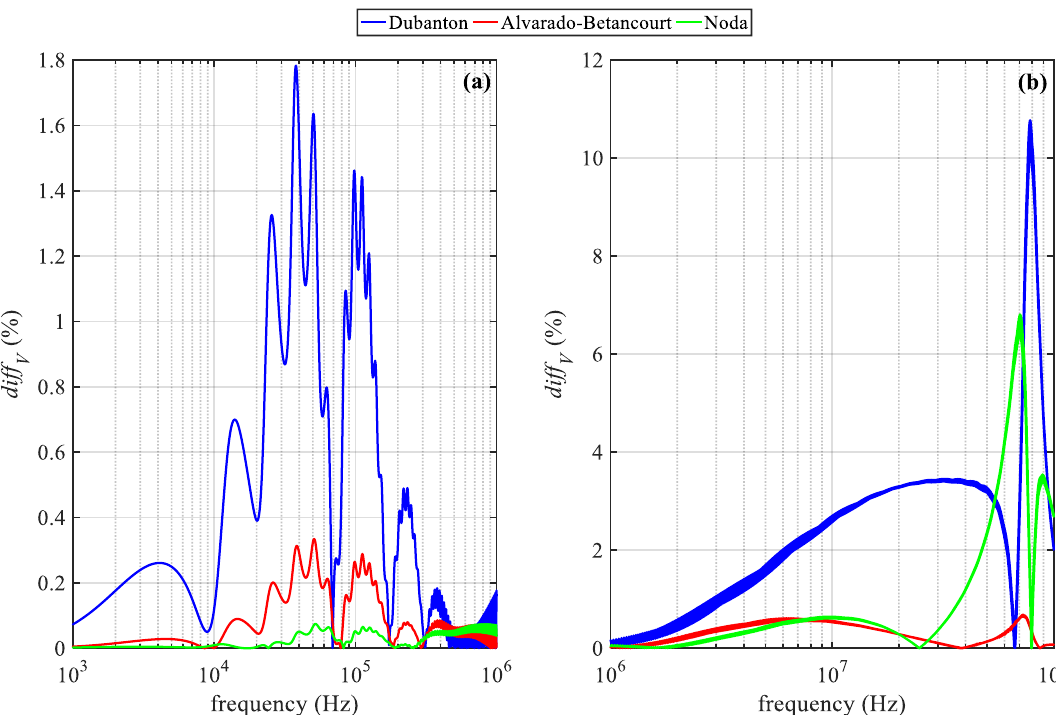
Figure 24. Percentage difference in the injected signal level at the receiving end of conductor 1. Wire-to-ground (WTG) injection in ( a ) NB and ( b ) BB.